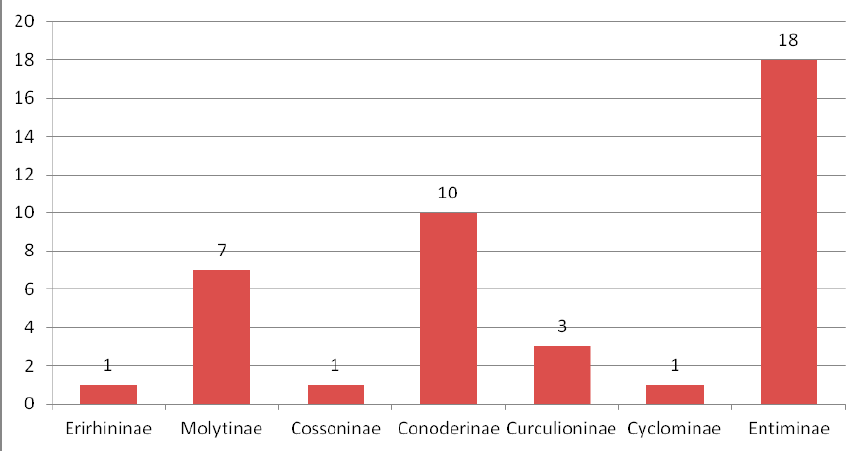
Figure 11. Composition of species of Curculionidae in the Green River Formation.